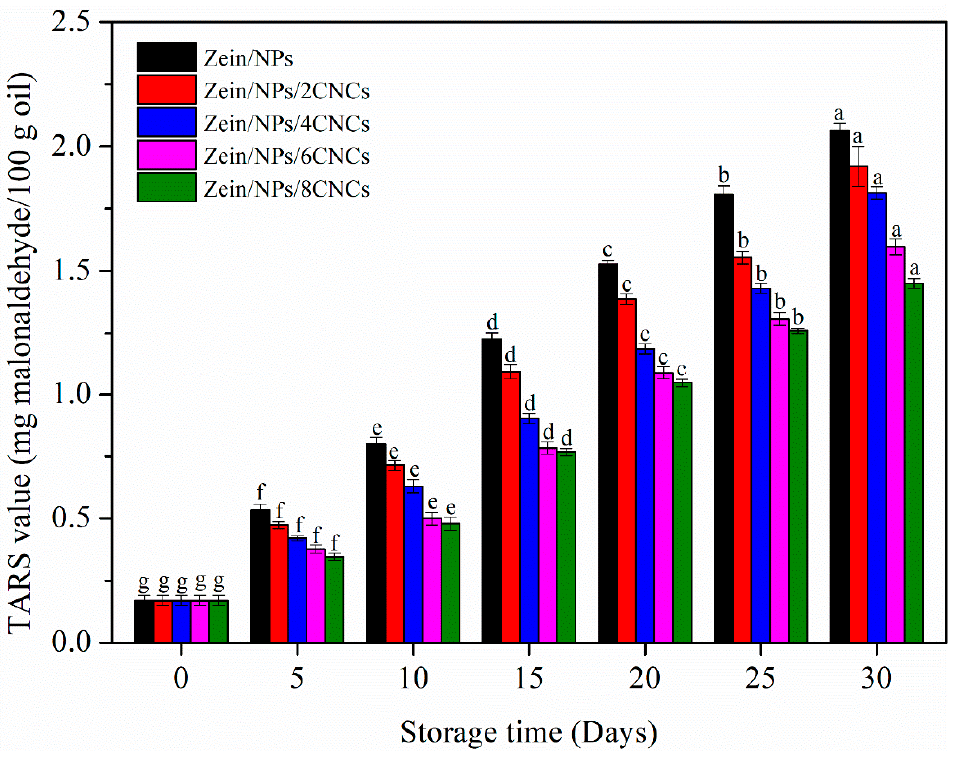
Figure 6. TBARS value of oil packaged in Zein/NPs, Zein/NPs/2CNCs, Zein/NPs/4CNCs, Zein/NPs/6CNCs and Zein/NPs/8CNCs pouches. Different lowercase letters within the same packaging indicate significantly different as determined by Duncan’s test ( p < 0.05).